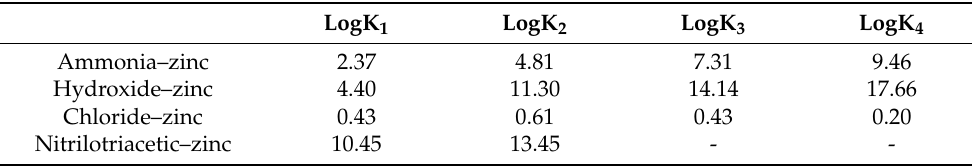
Table 4. The cumulative formation constants for zinc